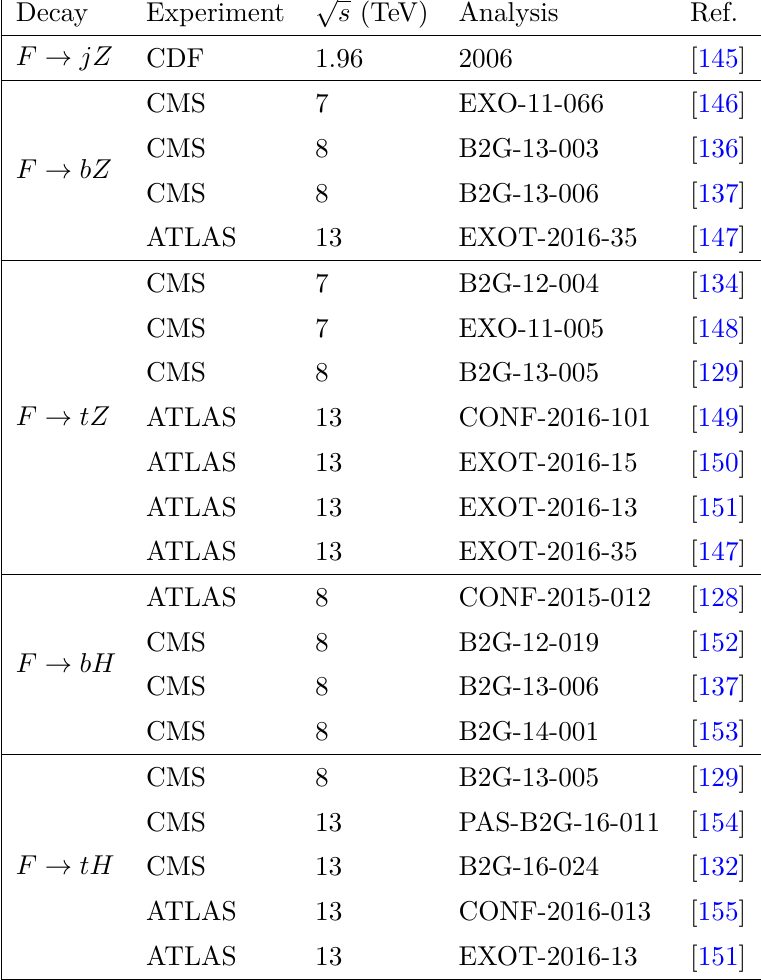
Table 11. ( cont. ) Experimental analyses of heavy quark decays we use to judge the fitness of our points. Here, j refers to a light quark or b jet, and q refers to a light quark